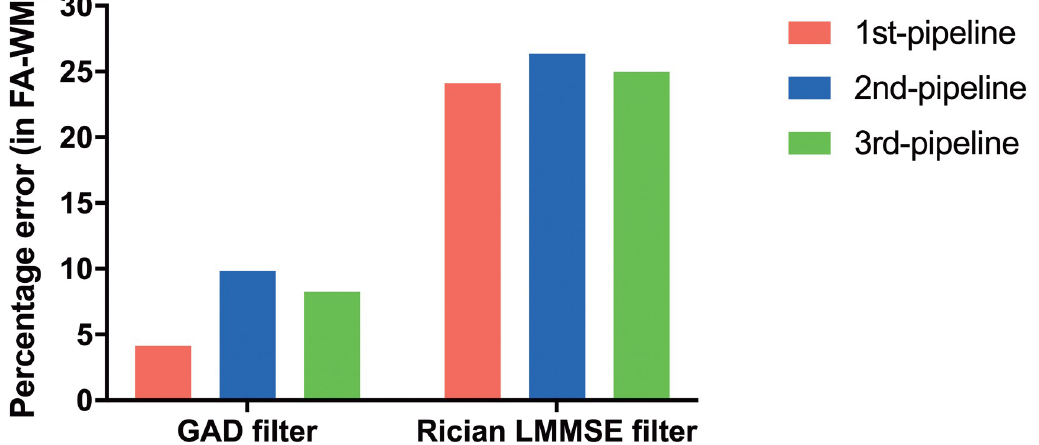
Fig 11. Percentage error in calculation of FA in WM for the dataset LM-20 when using the gradient anisotropic diffusion (GAD) filter and Rician linear minimum mean square error (LMMSE) filter. All pipelines produced lower percentage error with the GAD filter.